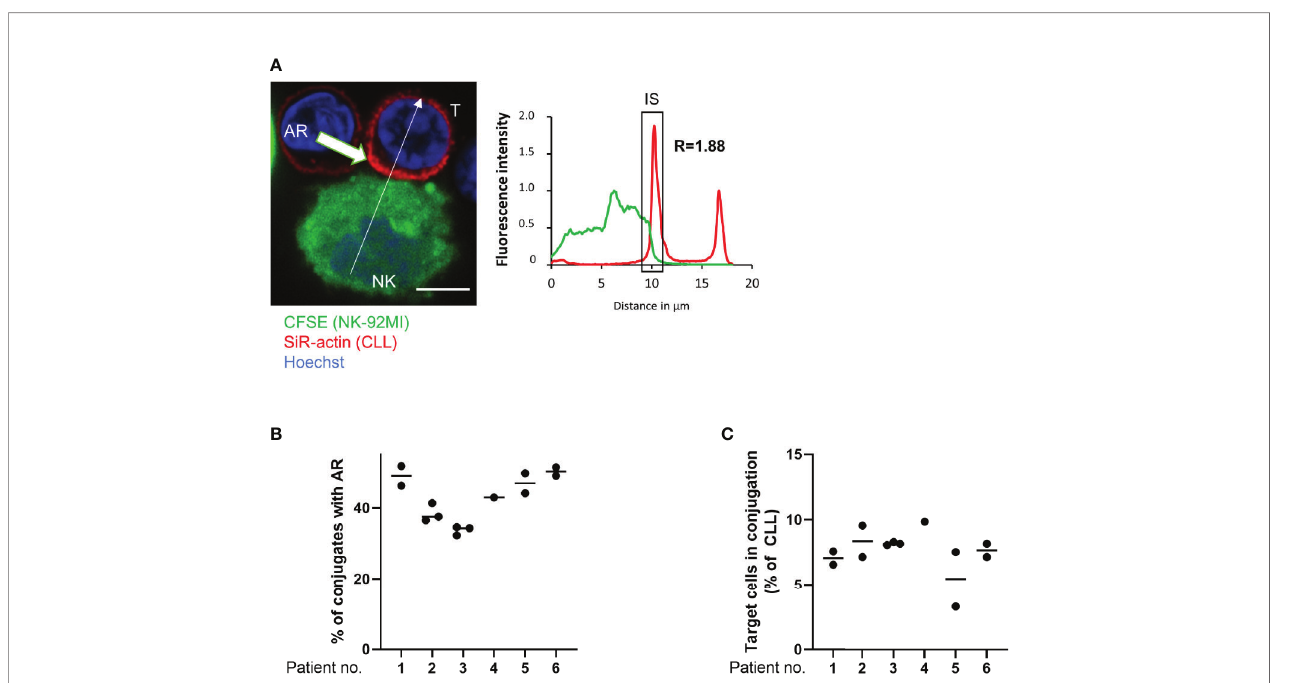
FIGURE 5 | The actin response in patient-derived primary CLL cells. (A) Representative confocal microscopy image of an immune synapse between a primary CLL cell (T) and NK-92MI cell (NK). The chart to the right shows the relative fl uorescent intensity of SiR-actin along the trajectory (white arrow). The fl uorescence was normalized to 1 at the opposite site of the synapse. The region of the immunological synapse is indicated with “ IS ” . Bar: 10 µm (B) Quantitative imaging fl ow cytometry analysis of the AR in primary CLL cells in conjugation with NK-92MI effector cells. CLL cells were identi fi ed as CD5 + /CD19 + cells. Actin staining was performed using spirochrome labelling. (C) Quanti fi cation of primary CLL cells in conjugation with NK-92MI cells after 45 minutes of co-culture as percentage of total target